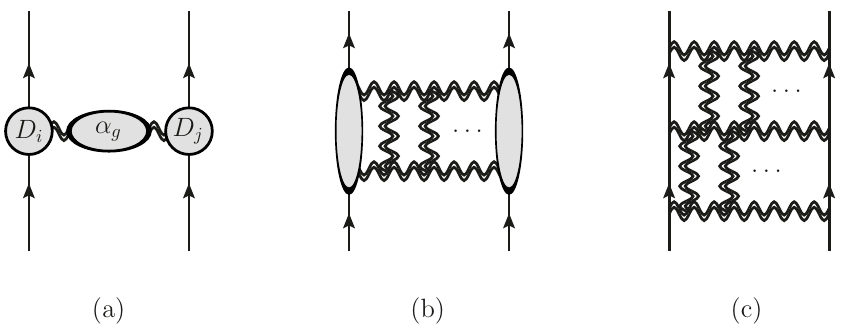
Figure 4 . From left to right, exchange of one, two and three Reggeized gluons, respectively. We draw the Reggeized gluons as double wavy lines, in order to distinguish them from standard gluon exchange in perturbation theory. Single Reggeon exchange in the (cid:12)rst diagram contribute at LL accuracy, while two-Reggeon exchange in the second diagram contribute at NLL accuracy. Last, three Reggeons exchange start contributing at NNLL accuracy. The shaded blobs in the (cid:12)rst and second diagram account for single- and two-Reggeon impact factors, which give additional contributions at subleading logaritmic accuracy to these